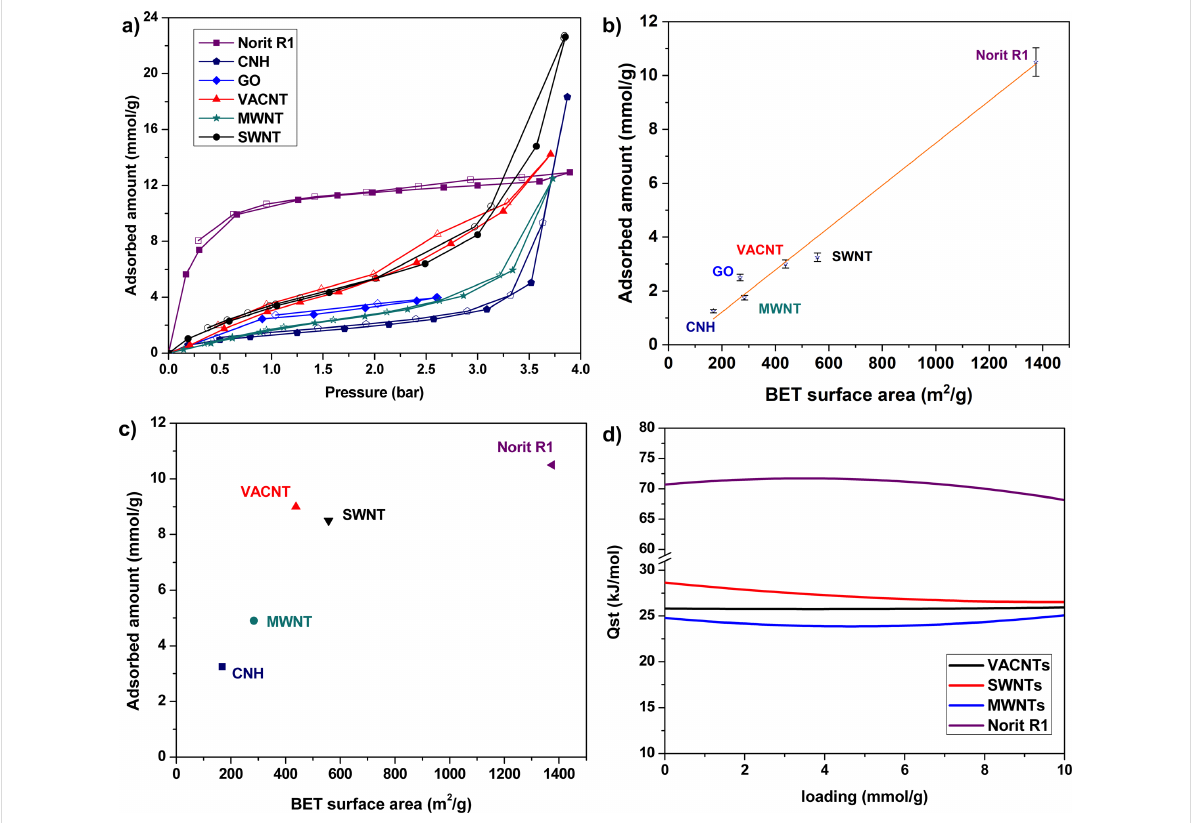
Figure 5: a) SO 2 adsorption isotherms at 25 °C of different adsorbents studied up to the saturation pressure of SO 2 . The results of GO are from [12]. SO 2 adsorption as a function of BET specific surface area at b) 1 bar and at c) 3 bar. d) Heat of adsorption of carbon nanotubes and Norit R1 Extra.